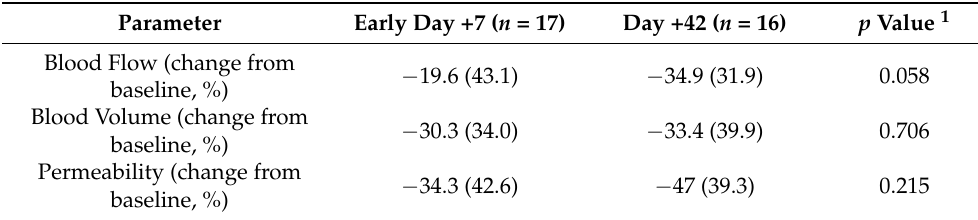
Table 3. Changes in perfusion parameters from baseline values. Mean values are shown, with the standard deviation in